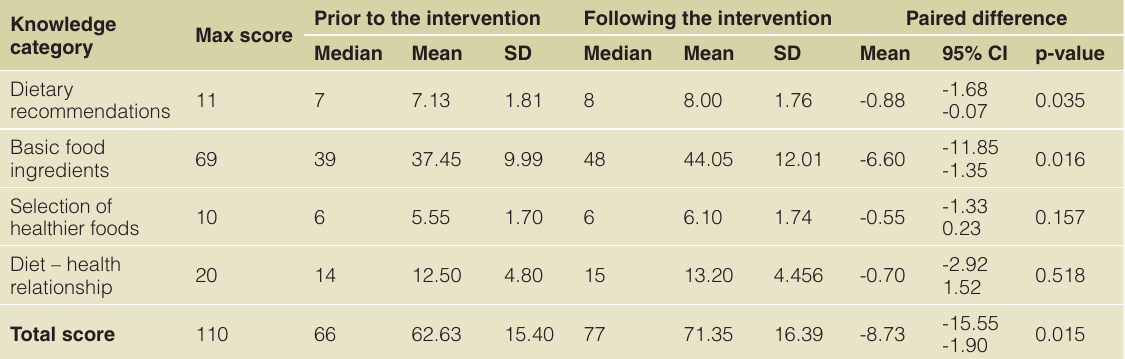
Table 3. Score comparison of population distribution per knowledge category prior to and following the intervention (n=20). Knowledge